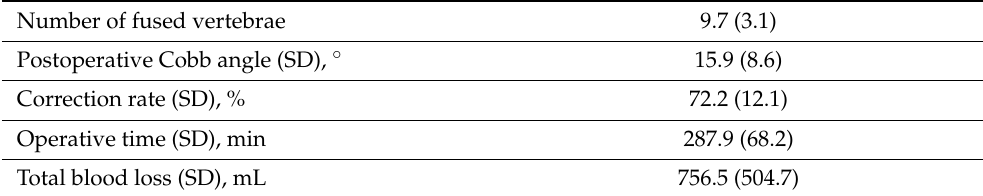
Table 2. Summary of Perioperative